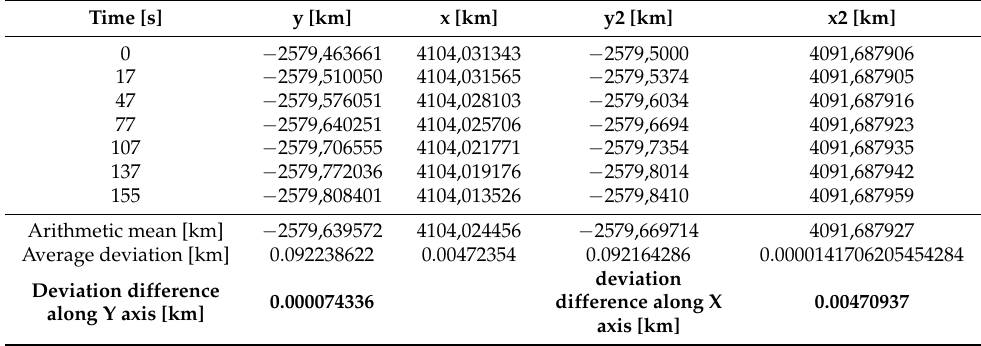
Table 3. Calculation of average deviations.